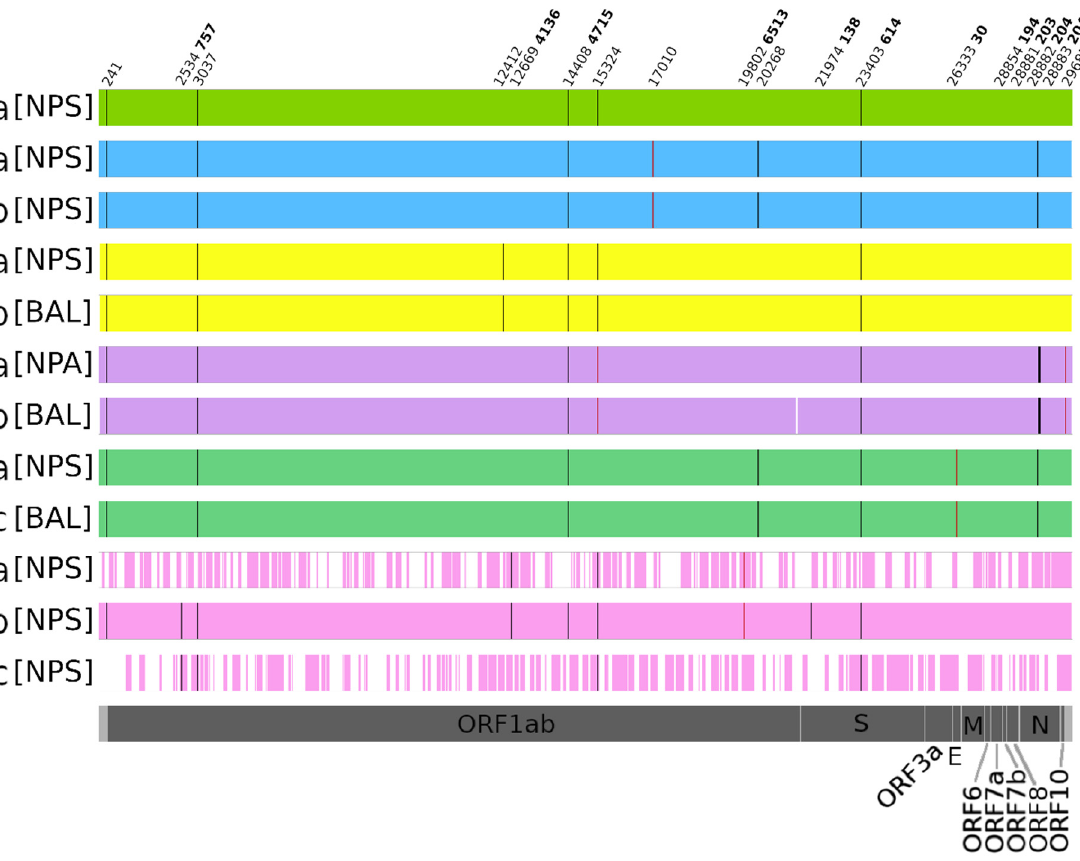
Figure 1. Sequencing results. Black bars represent positions with nucleotides that differ from the reference sequence MN908947. Red bars represent positions with minority nucleotide variants that differ from the reference sequence MN908947. White space represents regions whose coverage is lower than 10 × . Nucleotide (normal font) and amino acid (bold font) changes are indicated at the top of the figure. Although the genome coverage obtained for sample 1b was too low to be reported in the figure, thus making the temporal variability analysis for this patient unfeasible, sample 1a is reported to show the presence of the nucleotide mutations at positions 241 and 3037 as well as D614G and P4715L in all samples. NPS = nasopharyngeal swab, NPA = nasopharyngeal aspiration, BAL = bronchoalveolar lavage, S = spike, E = envelope, M = matrix, N = nucleocapsid genes.